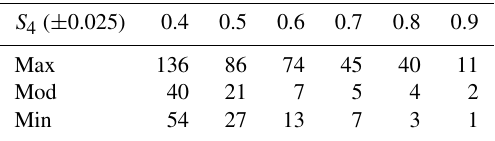
Table 2. Total of cases analyzed for different levels of the S 4 scin- tillation index during the periods of maximum (Max), moderate (Mod), and minimum (Min) solar activity levels.